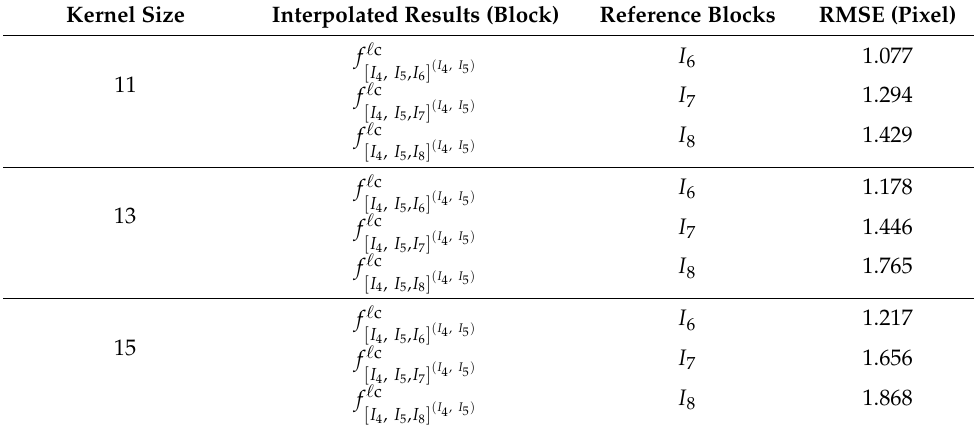
Table 9. Quantitative evaluation between block interpolated result and reference block using different separable convolution kernel